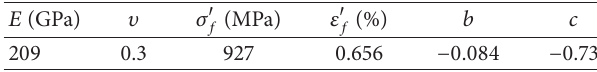
Table 6: Material properties for fatigue analysis [12].